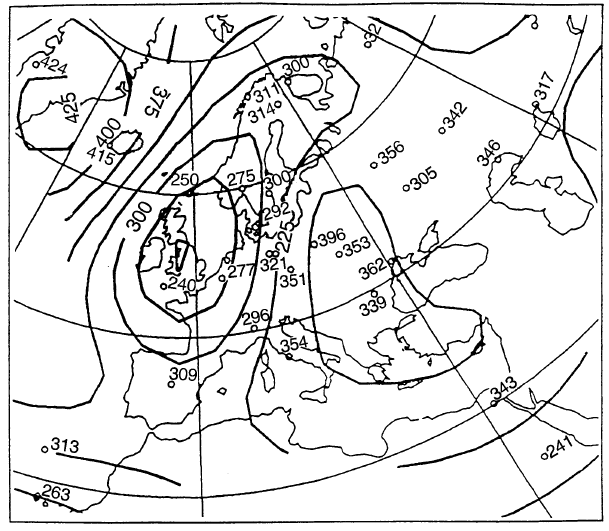
Fig. 5. 6 March 1993; ozone map (Courtesy of LAP Univ. of Thes- saloniky,